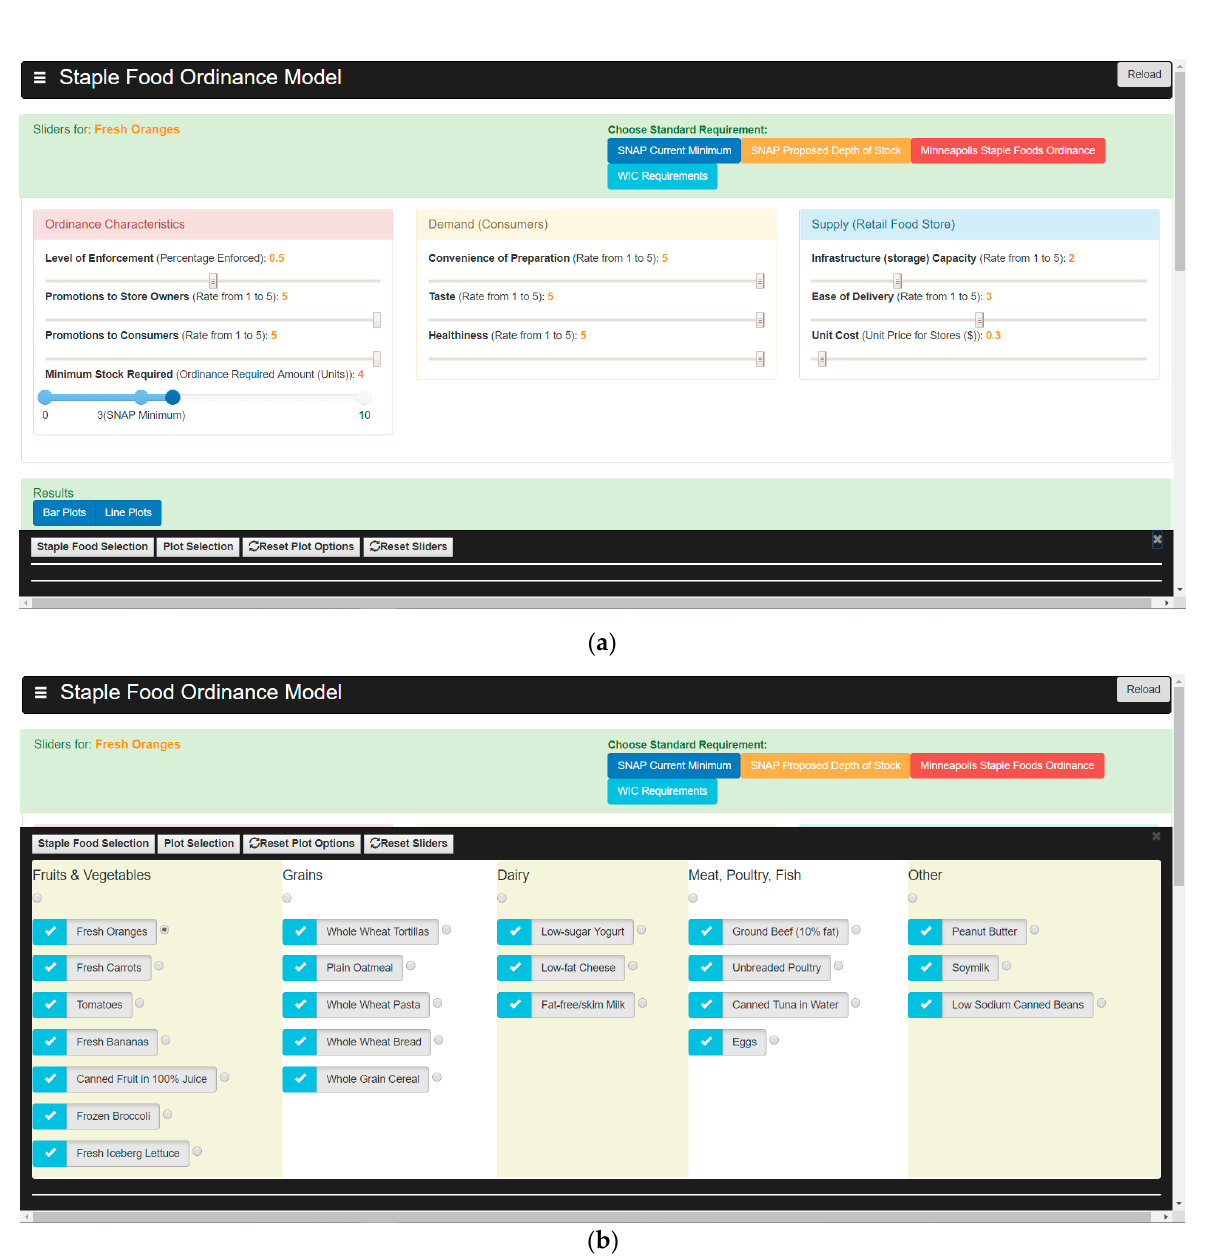
Figure 6. User Interface input options: ( a ) Sliders for input variables, four buttons for the existing sample ordinances; ( b ) Options to show results for specific food groups.